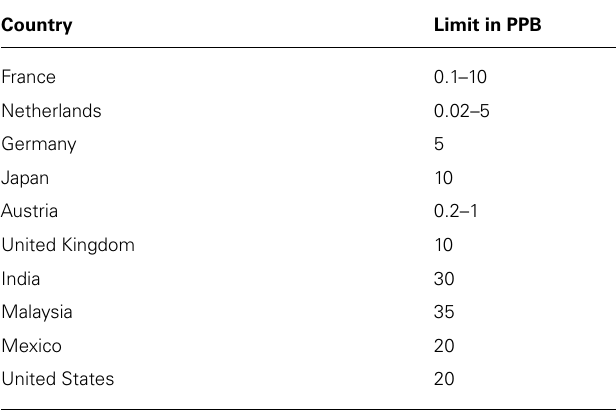
Table 1 |Allowable levels of aflatoxins in foods and feeds.